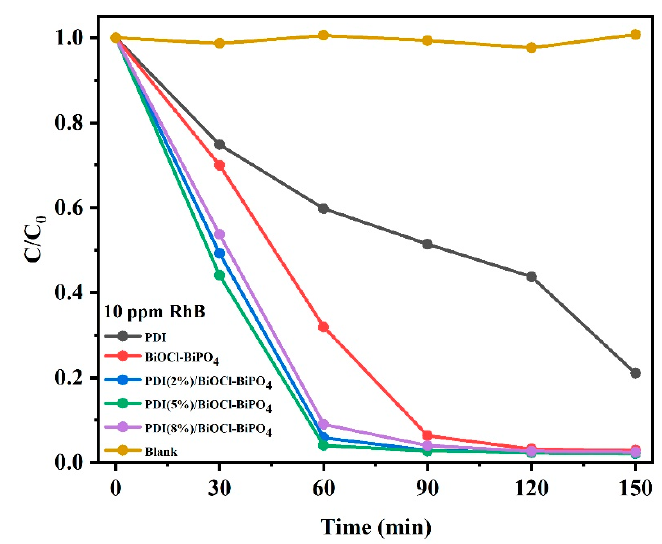
Figure 5. The photocatalytic activity of RhB degradation for all of as-prepared samples as a function of irradiation time under metal halide lamp irradiation.